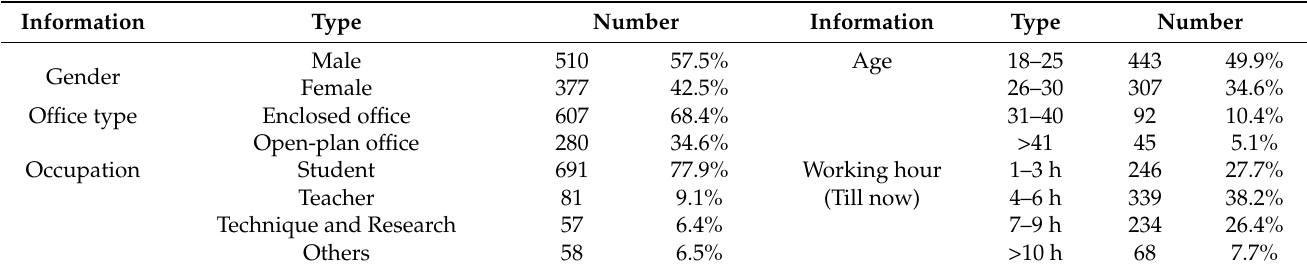
Table 5. Participants’ basic information in the POE-based field survey.